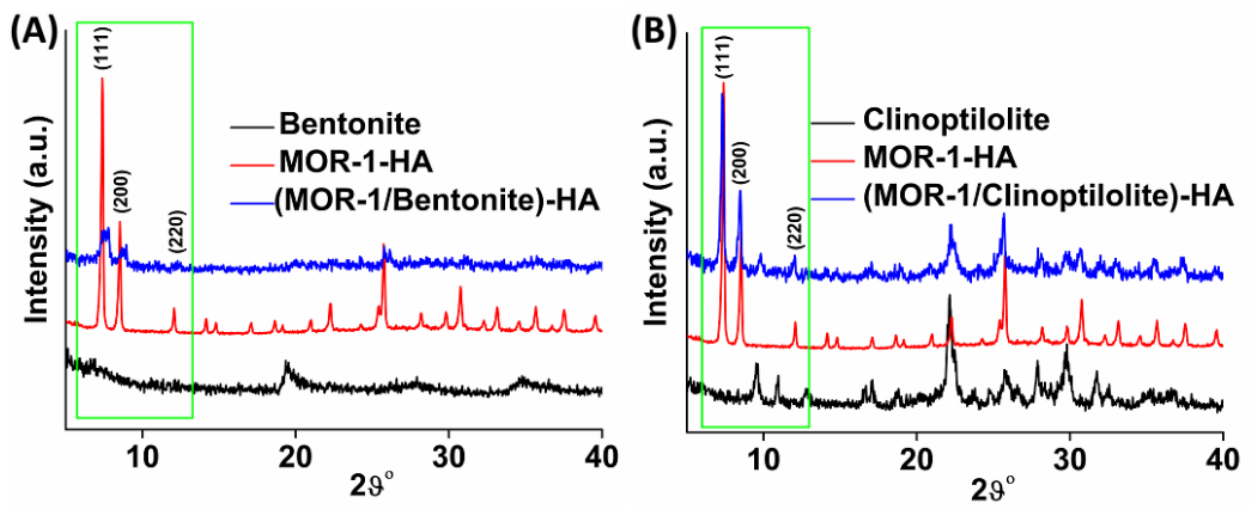
Figure 3. ( A ) PXRD patterns of bentonite, MOR-1-HA, and (MOR-1/Bentonite)-HA. ( B ) PXRD pat- terns of clinoptilolite, MOR-1-HA, and (MOR-1/Clinoptilolite)-HA. The characteristic diffraction peaks of MOR-1 and aluminosilicates are highlighted in the green rectangles.